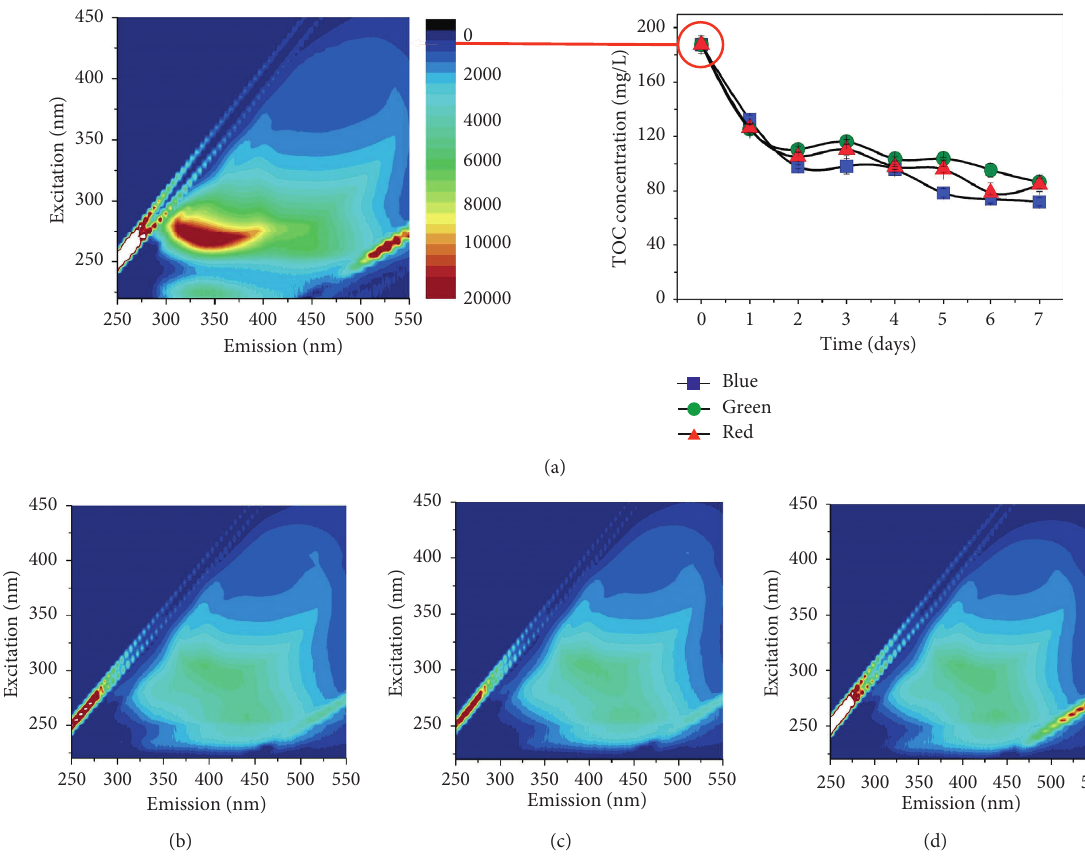
Figure 2: Total organic carbon (TOC) variation under irradiation with red, green, and blue lights and variation of EEMs following cultivation: initial EEM for campus wastewater (a); and EEMs on the 7 th day, following irradiation with (b) red light, (c) green light, and (d) blue